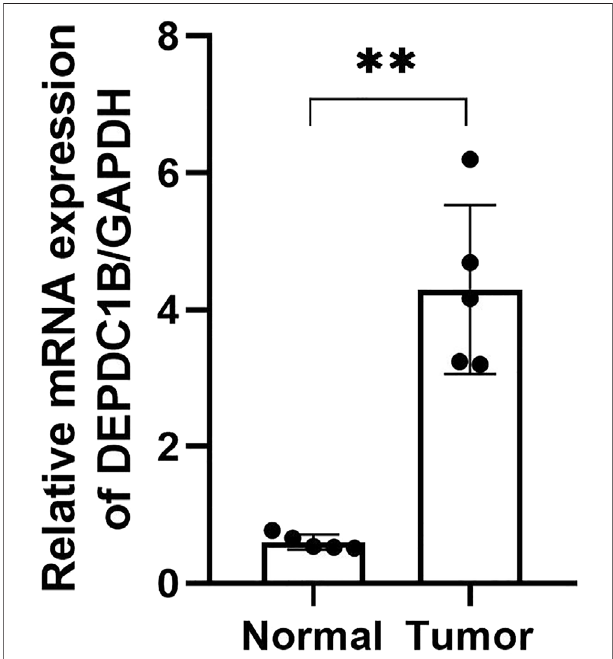
FIGURE 7 | DEPDC1B mRNA expression is frequently upregulated in LIHC tissues. T: LIHC tissues; N: noncancerous tissues. The results were shown with Mean ± SD. N (cid:1) 5, ** p <